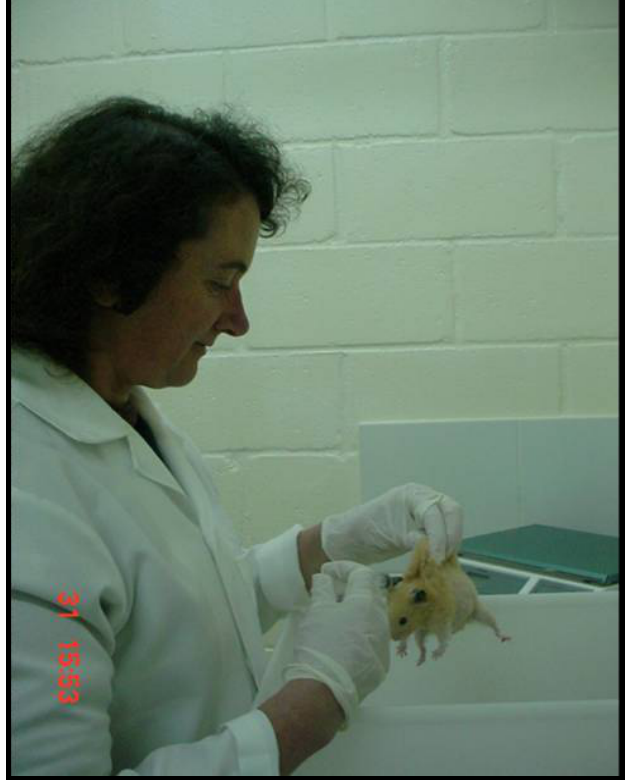
FIGURE 1 - Digital picture shows subcutaneously (SC) finasteride shot in the dorsal region of the animal ( INBIO-UNIPAC, 2006, Dec.). After three months the animals died due to hypov- olemia, after being anesthetized with 200mg/kg of ketanine chloridrat and 2.5mg/kg of diazepam 9